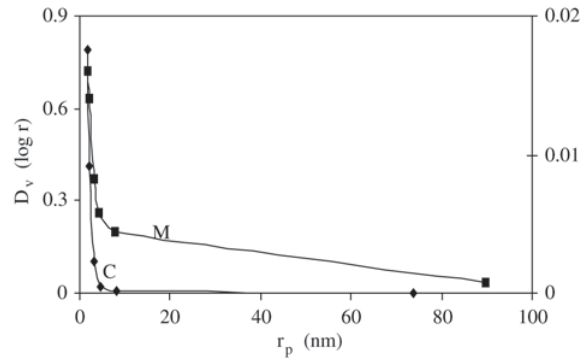
Figure 2. Isotherm of N adsorption-desorption obtained for po- 2 rous silica via microwave heating.